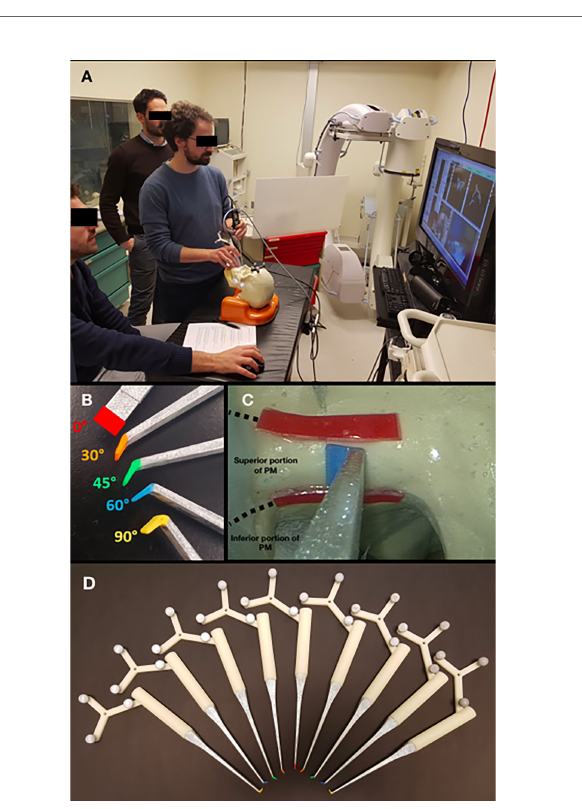
FIGURE 2 | (A) Simulationsetting. (B) Pointers with different types of angled tips. (C) Endoscopic view, with red lines indicating the superior and inferior potions of the posterior margin (PM); (D) Pointers withangledtips withdifferent angles (0°, 30°, 45°, 60°, and 90°) and directions (right or left).